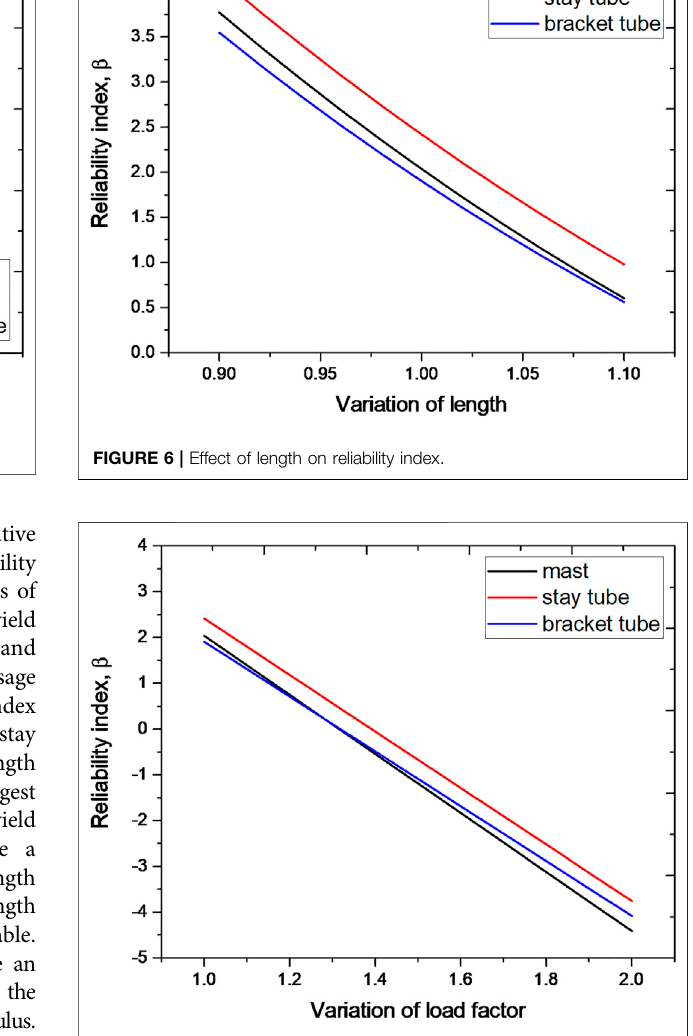
FIGURE 7 | Effect of load factor on reliability